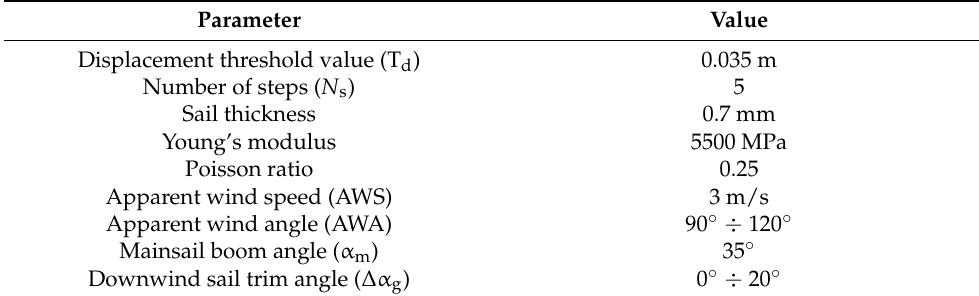
Table 4. Values of the parameters used for the case